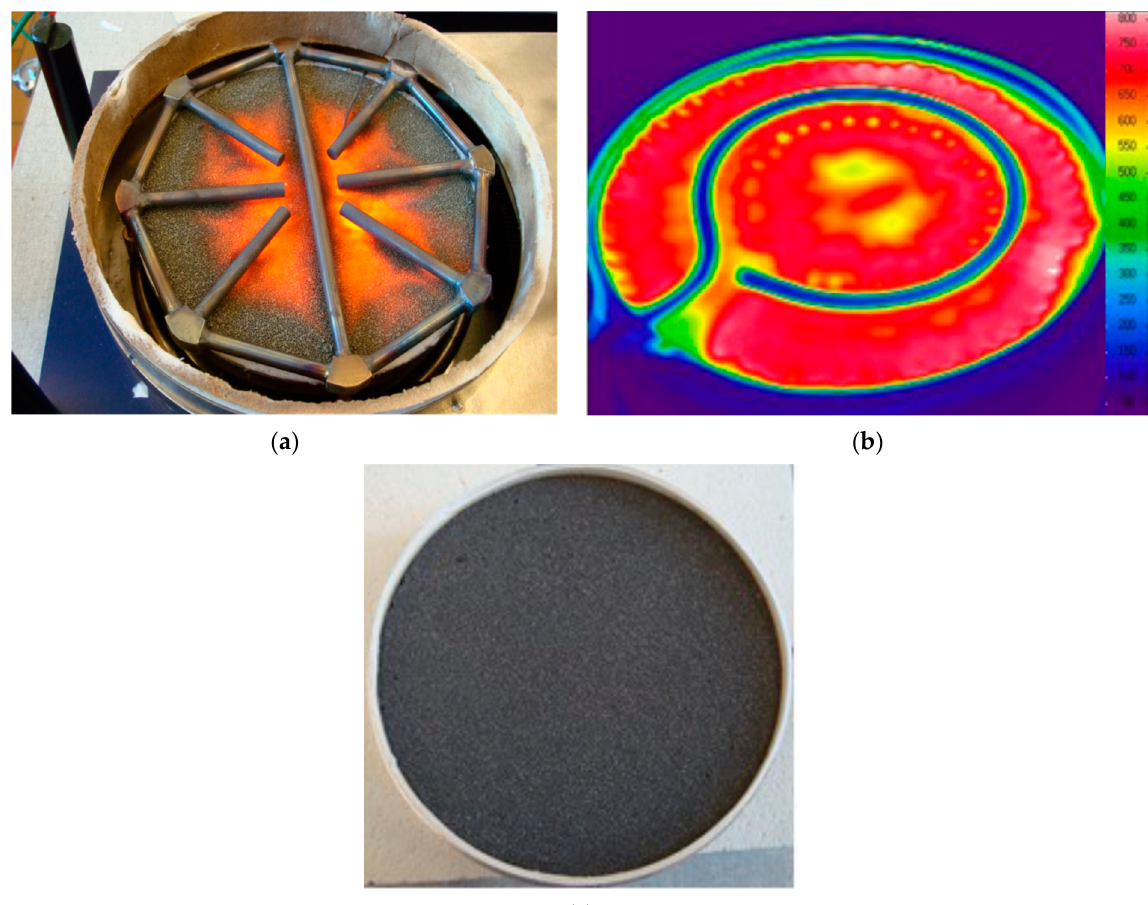
Figure 16. ( a ) Catalytic hydrogen burner with air supply channels; ( b ) infrared image of the Pt/SiC burner at an operating temperature); ( c ) Pt/SiC disk (reproduced from [180]).